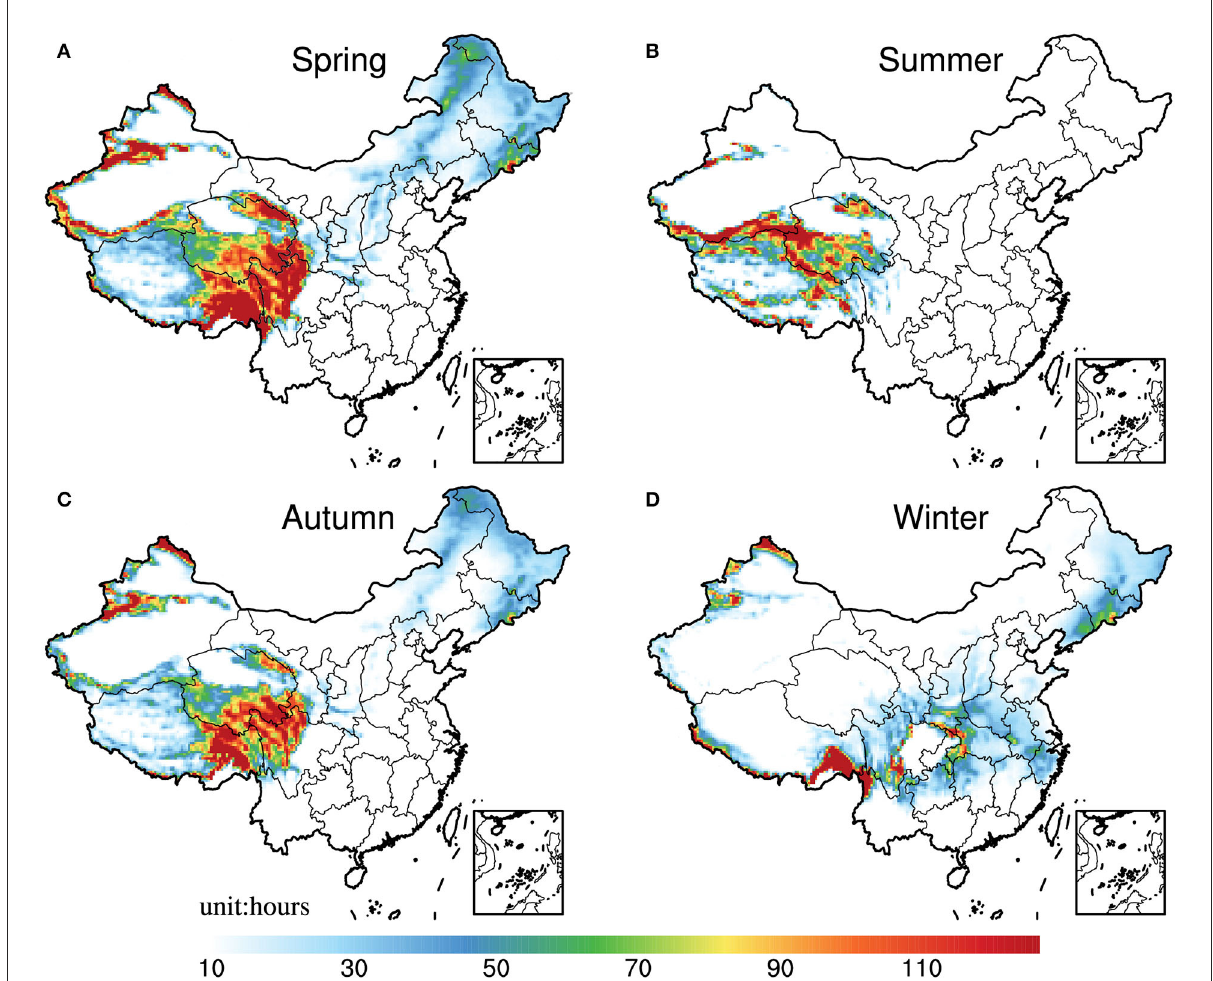
FIGURE5 (A-D) Same as Figure 2, but for seasonal mean SNOW from the ERA5-land